Question: Give a one-sentence summary of this figure.
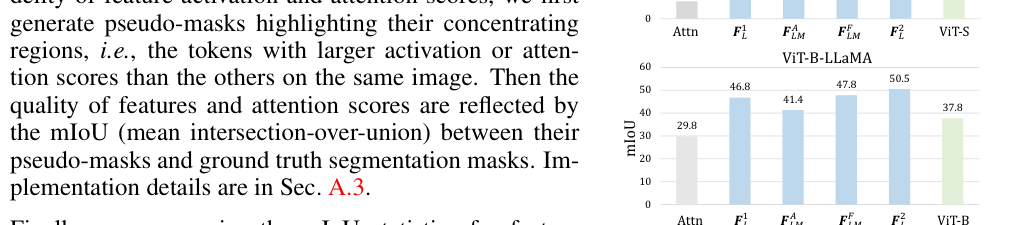
Answer: Pseudo-masks from ViT- LLaMA’s features (F2 L) have larger mIoU than attention scores and ViT.